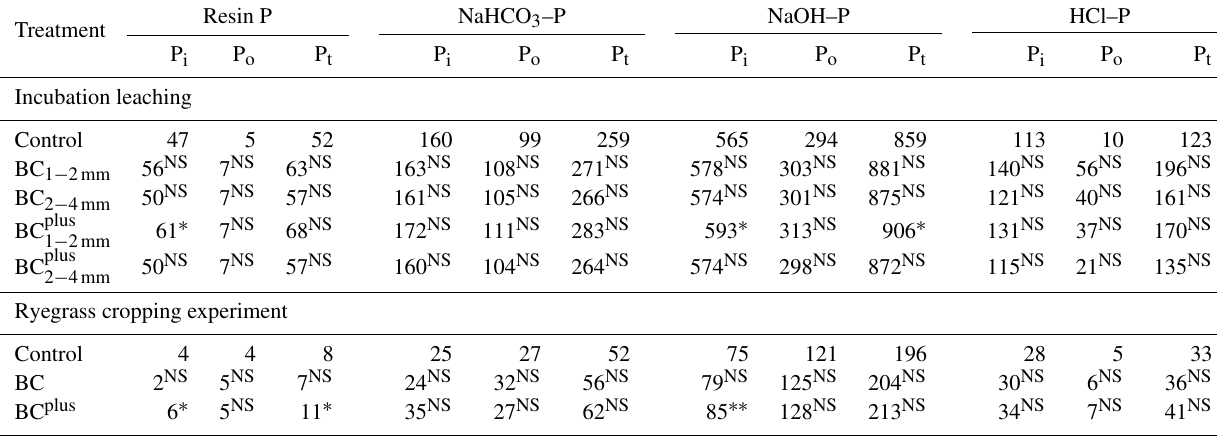
Table 1. Distribution of inorganic P (P i ), organic P (P o ) and total P (P t ) concentrations (mgPkg − 1 soil) of sequentially extracted P fractions in the soils as affected by different treatments (treated with two particle size fractions (1–2 and 2–4mm) and original sizes of BC and BC plus or unfertilized soils (control) after incubation-leaching and ryegrass cultivation